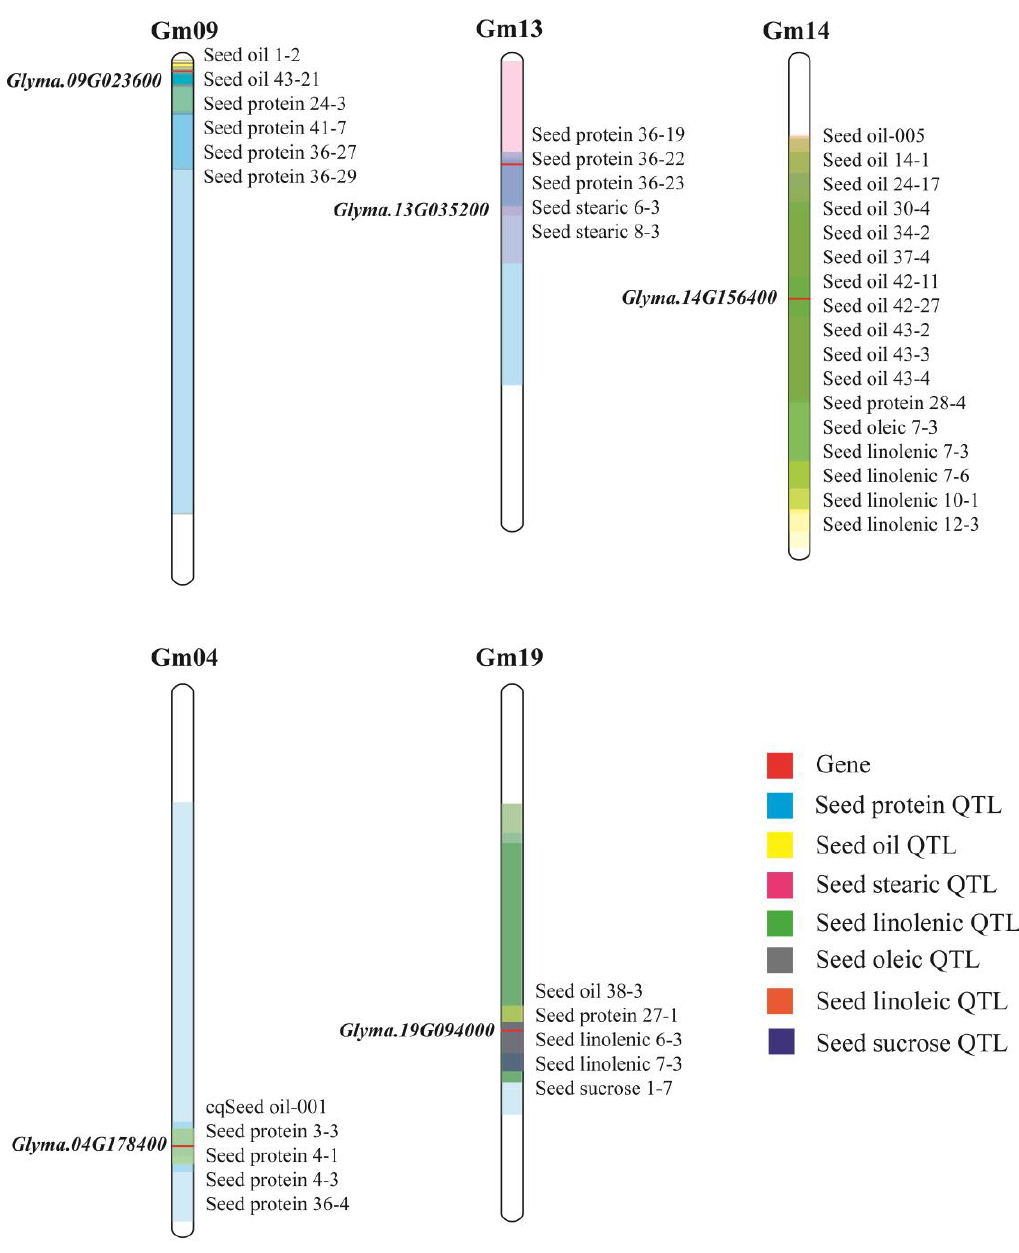
Figure 9. Quantitative trait locus (QTL) validation of candidate genes. Different color modules represent different types of QTL, light blue for seed protein QTL, yellow for seed oil QTL, pink for seed stearic QTL, green for seed linolenic QTL, gray for seed oleic QTL, orange for seed linoleic QTL and dark blue for seed sucrose QTL. The genes are marked in red. The transparency of the color is increased so that the overlapping area is easier to distinguish.